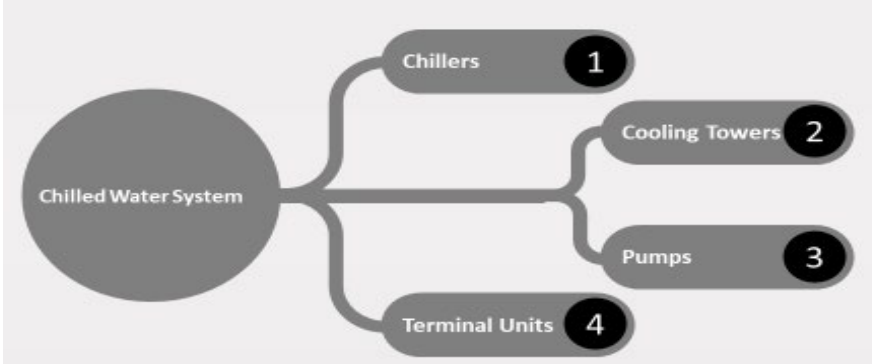
Figure 1. CWS components.